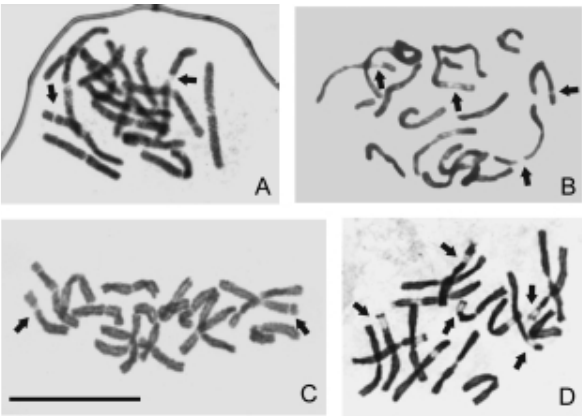
Figure 3 - Cold sensitive regions (CSRs) in Cestrum . (A) C. amictum , (B) C. intermedium , (C) C. sendtnerianum and (D) C. strigilatum . Arrows in- dicate terminal and interstitial CSRs. Bar represents 10 (cid:1)